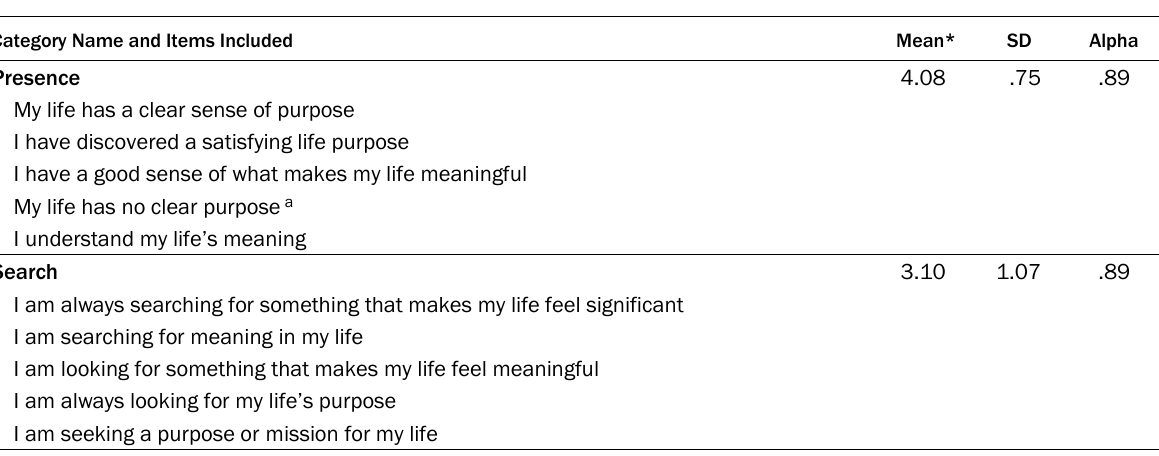
Table 6. Categories of Life Meaning